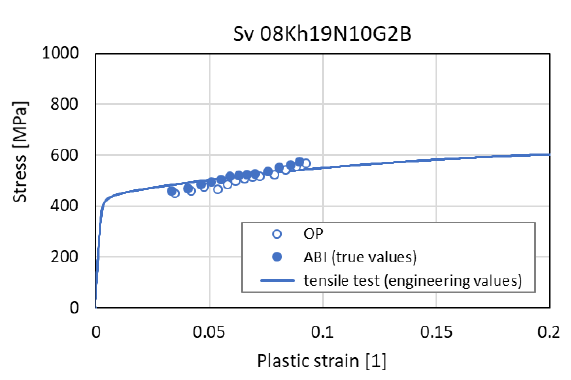
Figure 2. ABI test load - displacement curve for Sv 08Kh19N10G2B steel.